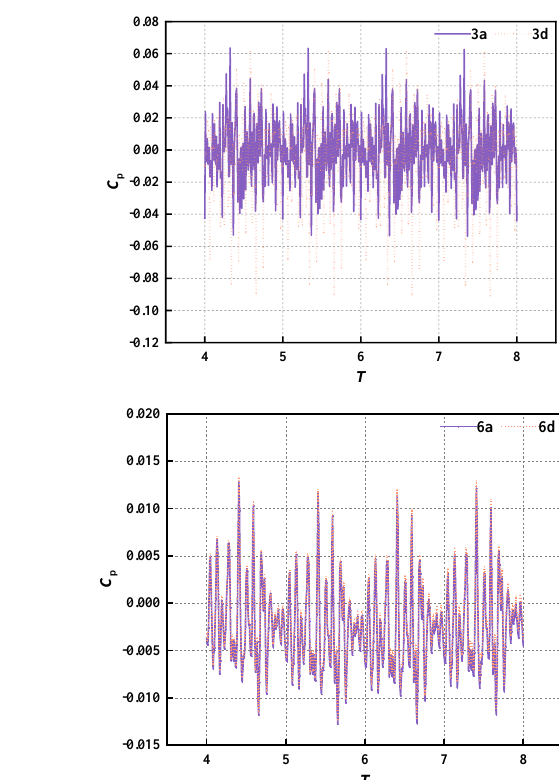
Figure 10. Time domain diagram of water pressure fluctuation under the waterlogging drainage condition.